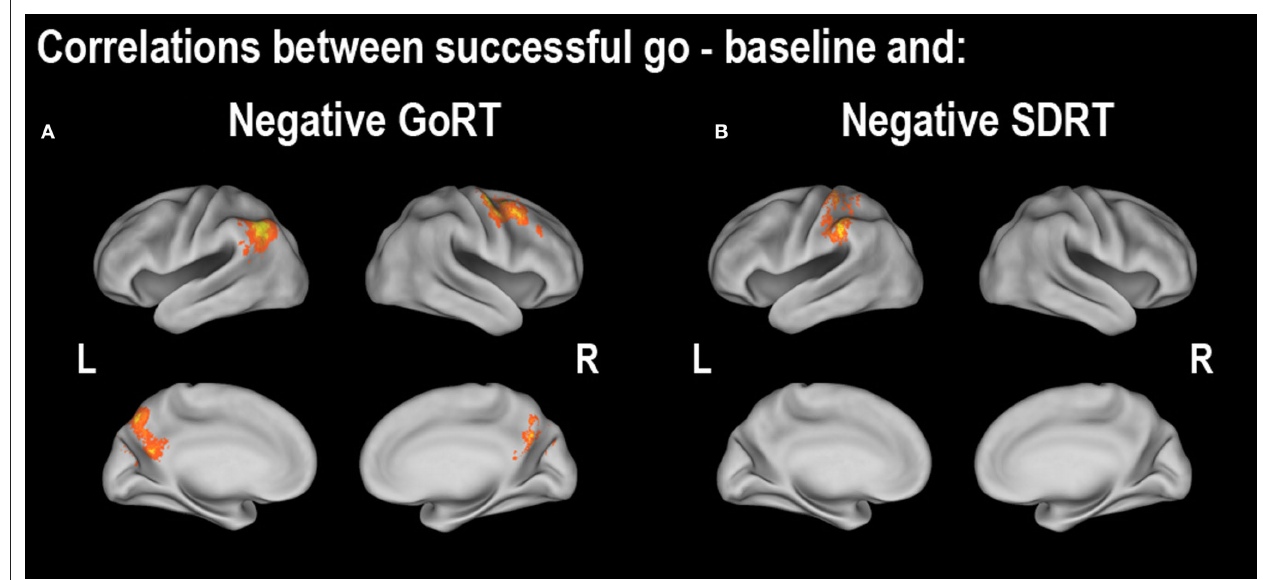
FIguRe 4 | Regions showing correlations between successful going vs. baseline and (A) median Go response time (GoRT) and (B) the standard deviation of Go response time (SDRT). All correlations were corrected at the whole-brain level at z > 2.3, p < 0.05. For cluster details, see Table 3.